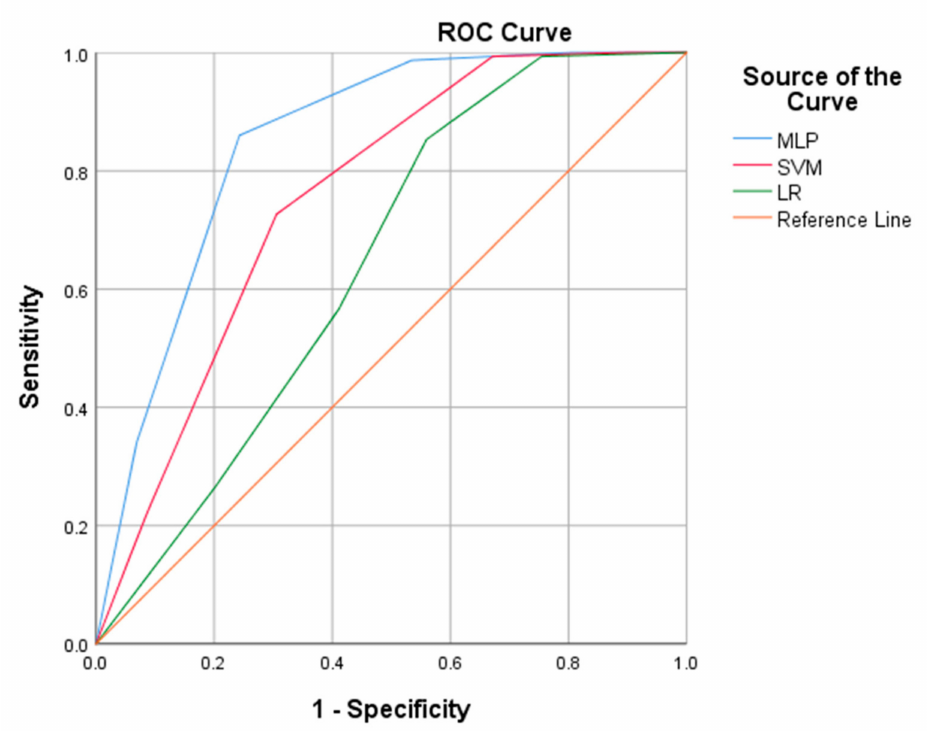
Figure 5. Comparative plot of the ROC curve for MLP, SVM, and LR.